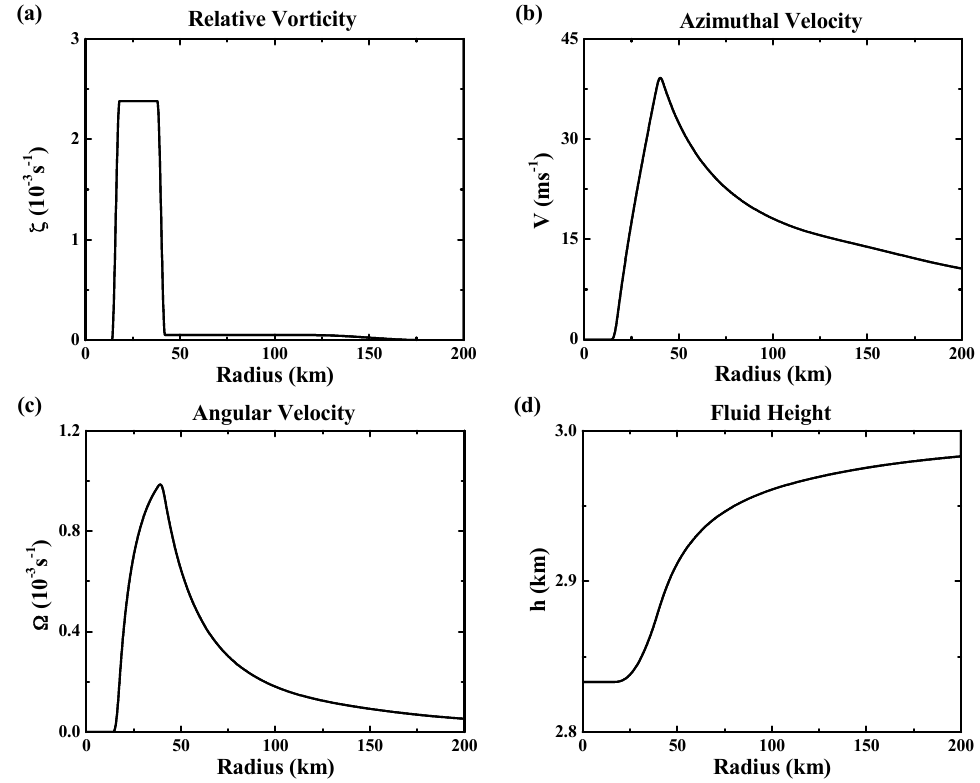
Figure 1. Radial distribution of ( a ) relative vorticity (10 − 3 s − 1 ), ( b ) azimuthal velocity (ms − 1 ), ( c ) angular velocity (10 − 3 s − 1 ), ( d ) fluid depth (km) with a hollow vortex as the basic state.